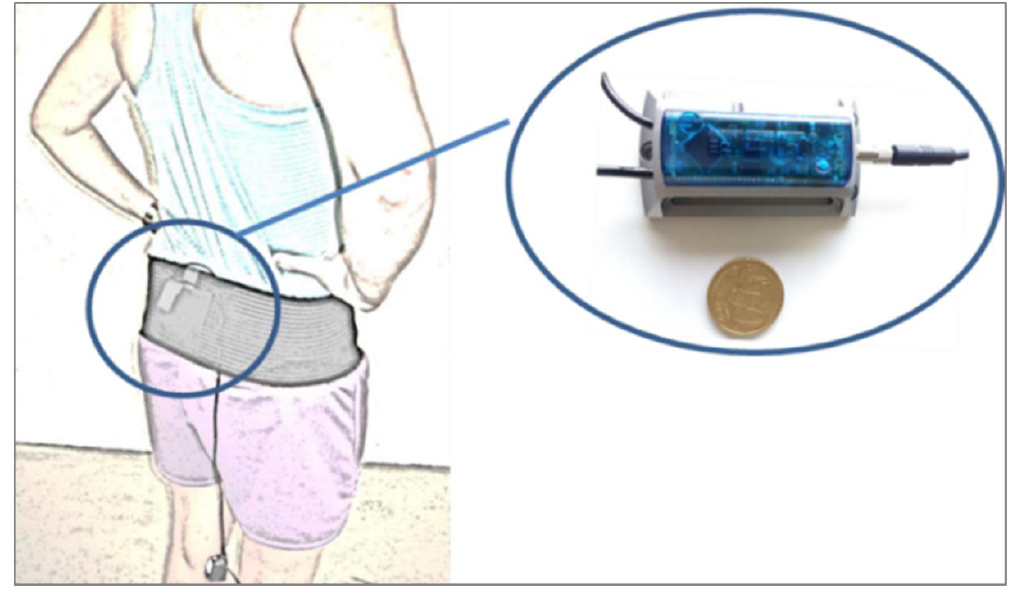
Figure 2. Positioning of the inertial sensor unit.